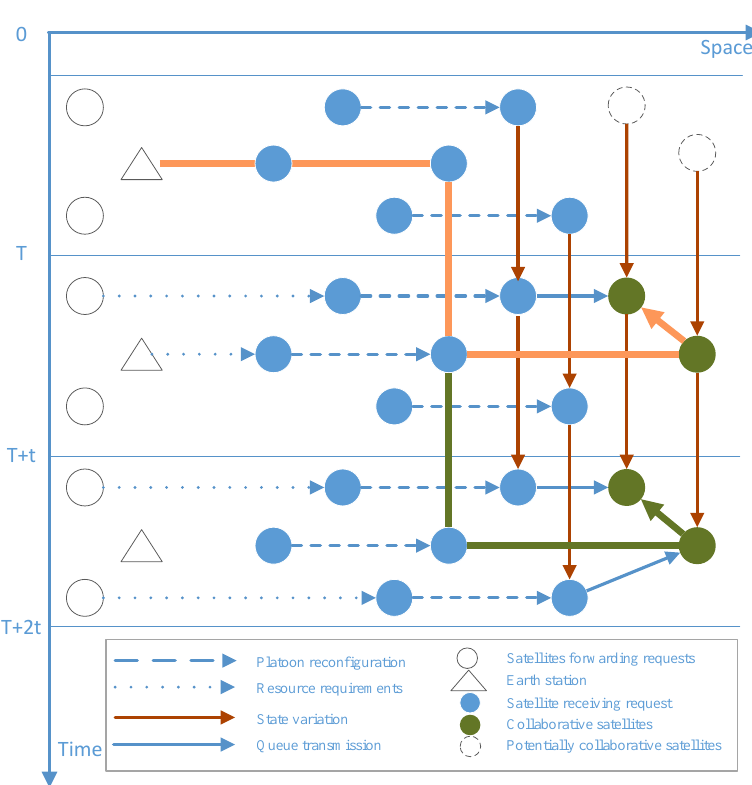
Figure 4. Multi-satellite resource request queue redistribution data transmission process. We consider the changes and interrelationships of the satellite states in three-time intervals. The satellite set sours receives resource requests from the ground base station or other surrounding satellites in the first-time interval to form a resource request